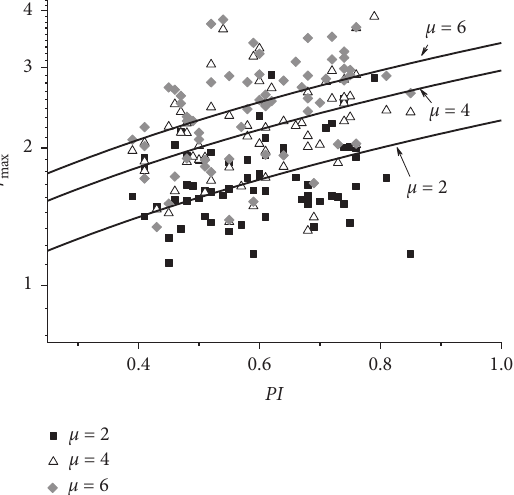
Figure 9: Scatter plot of the maximum ratio r